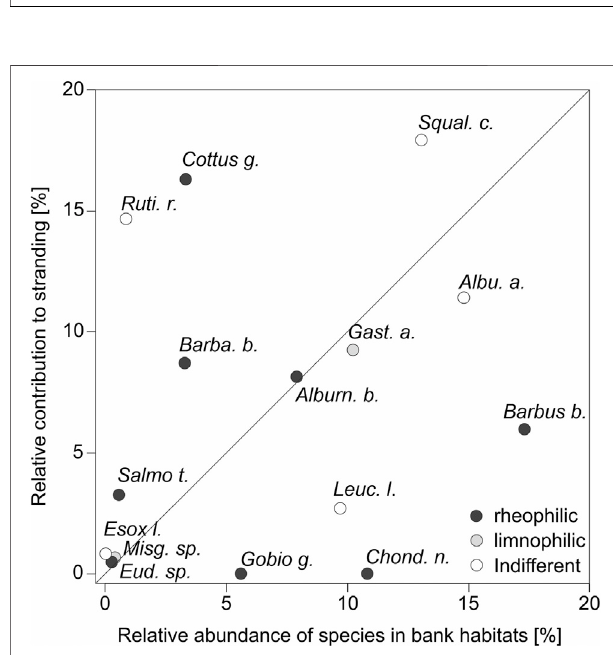
FIGURE4 | Barplots of stranded fi sh individuals and their mortality, combined for2016 and 2021. Left axis displays the frequencyof stranded individuals and right axis indicates the mean total length of stranded fi sh.